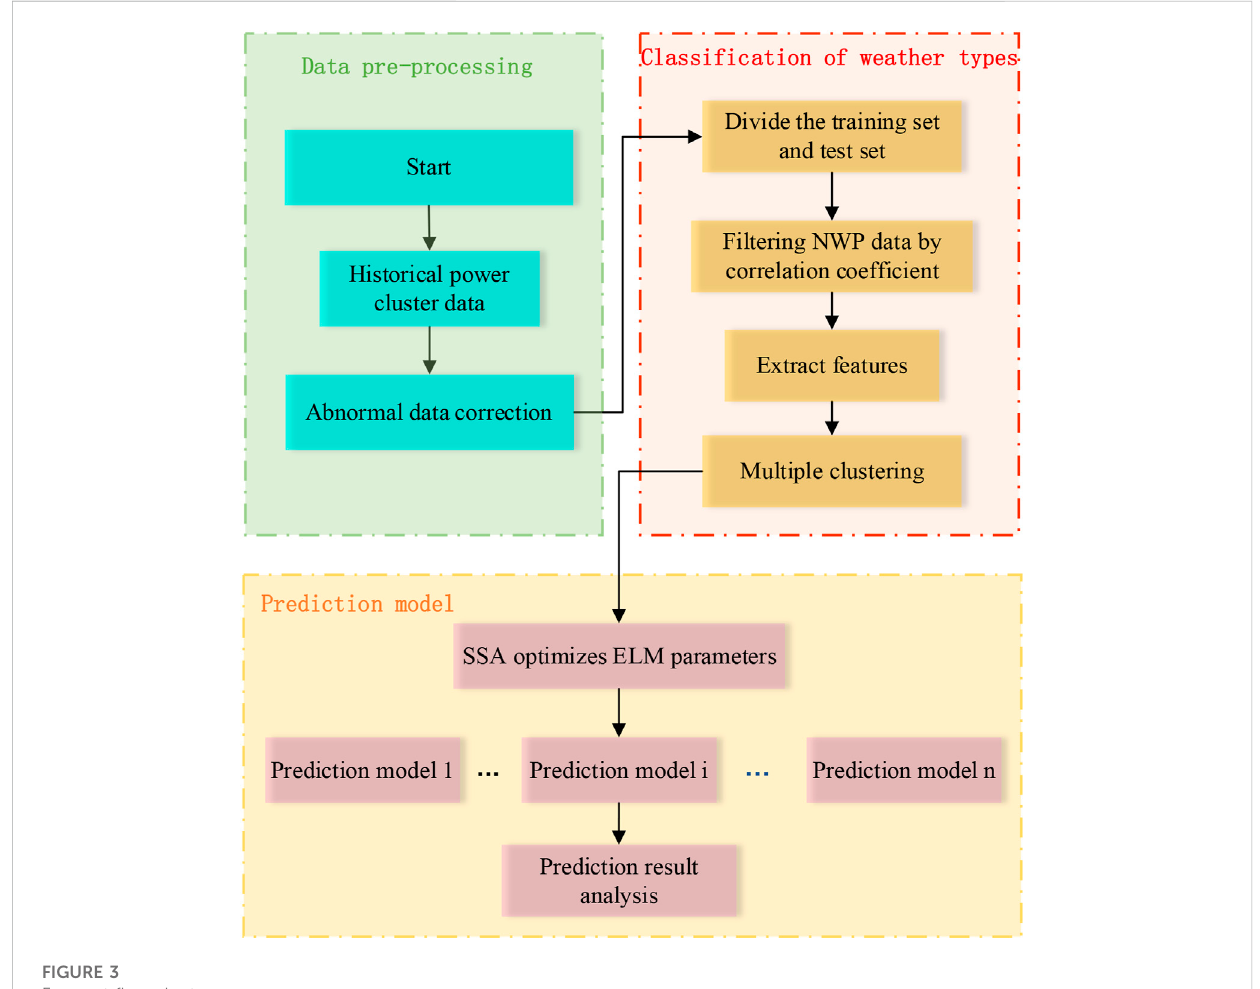
FIGURE 3 Forecast fl ow